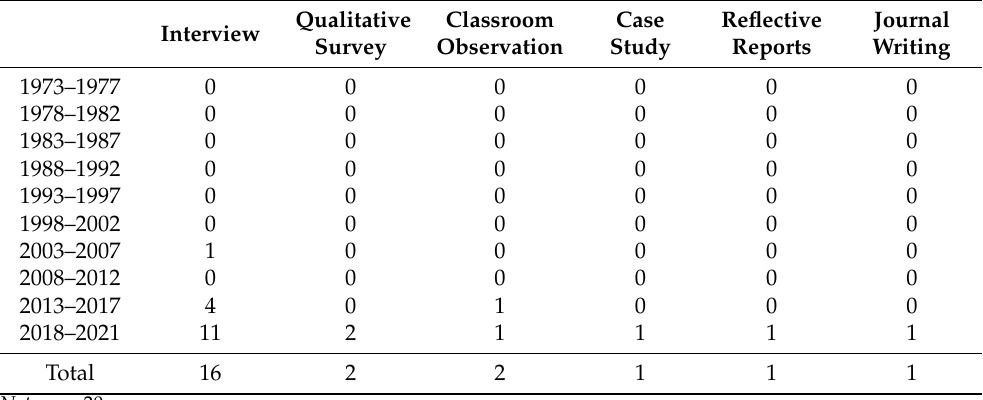
Table 4. Trend of Frequency of Top 6 Qualitative Data Collection Techniques by Five-Year Interval during 1973–2021. Qualitative Classroom Case Reflective Journal Interview Survey Observation Study Reports